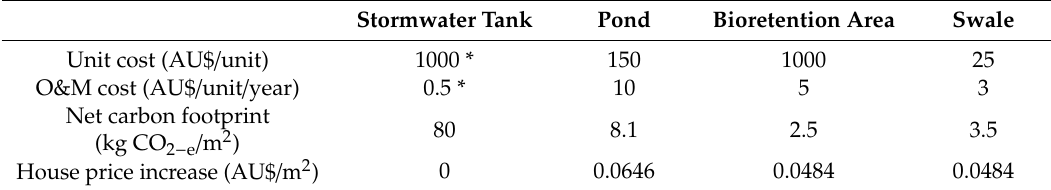
Table 8. The important parameters and coe ffi cients for sub-criteria